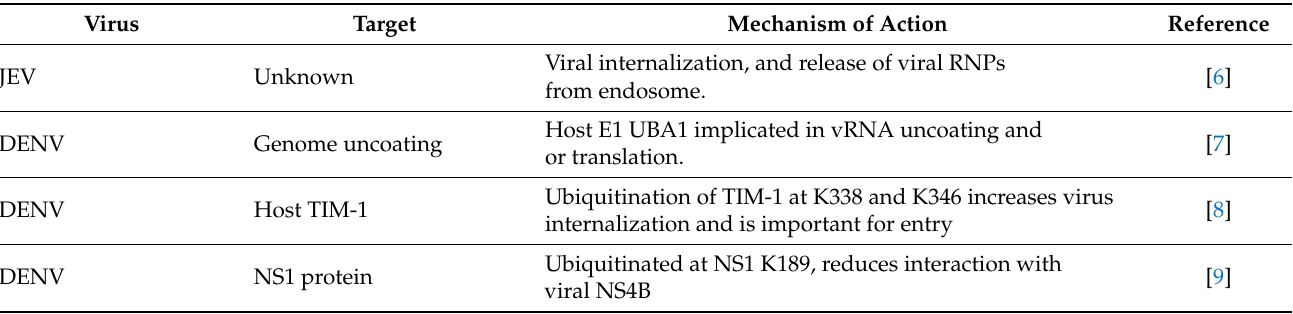
Table 1. Comprehensive table of how emerging viruses mentioned in this review can utilize the ubiquitination of both host and viral proteins to enhance or complete their life cycles. Virus Mechanism of